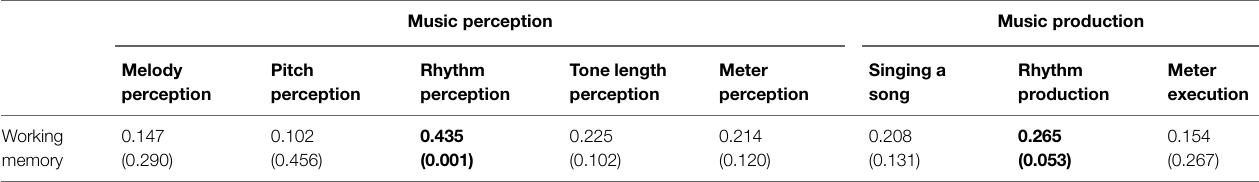
TABLE 4 | Associations among working memory and the subtests of music perception as well as the subtests of music production.